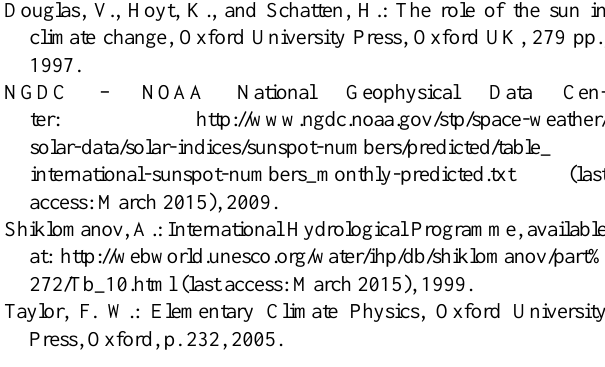
4020040600410004140041800 a) Figure 6. Water inflow trend into the World Ocean (a) and relation- Figure 6 6.Water infl sunspot ts (b). ship of the inflow from sunspots (b)